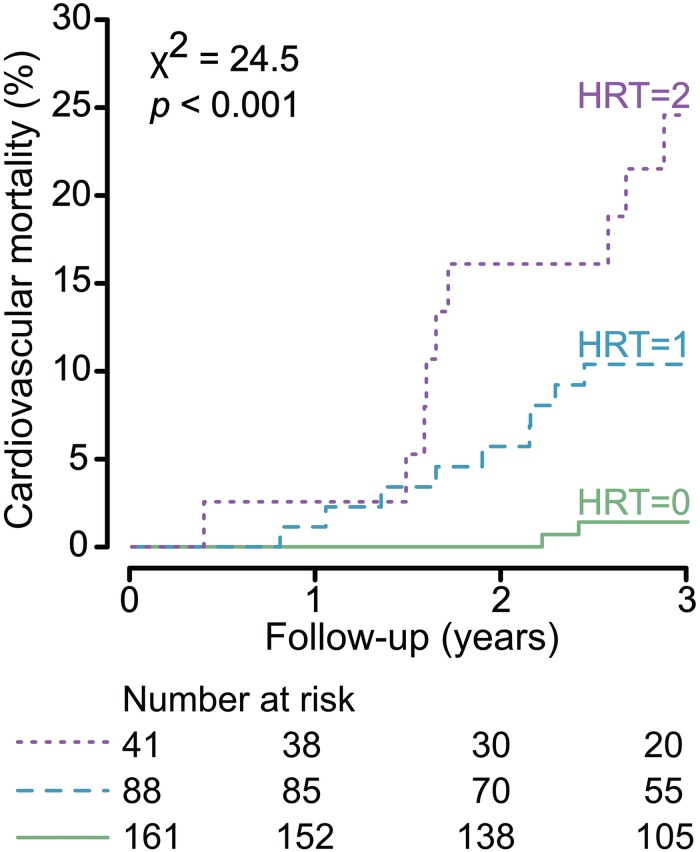
Cumulative cardiovascular mortality curves stratified by heart rate turbulence (HRT). The median follow-up was 3 years. Cause-specific hazards for cardiovascular mortality were compared between groups by the log-rank test. The number of patients of the individual groups involved in the analysis at 1, 2, and 3 years are shown under the graph. 3-Year cardiovascular mortality rates were 1.2, 10.2, and 22.0% for those with HRT category 0, 1, and 2, respectively.